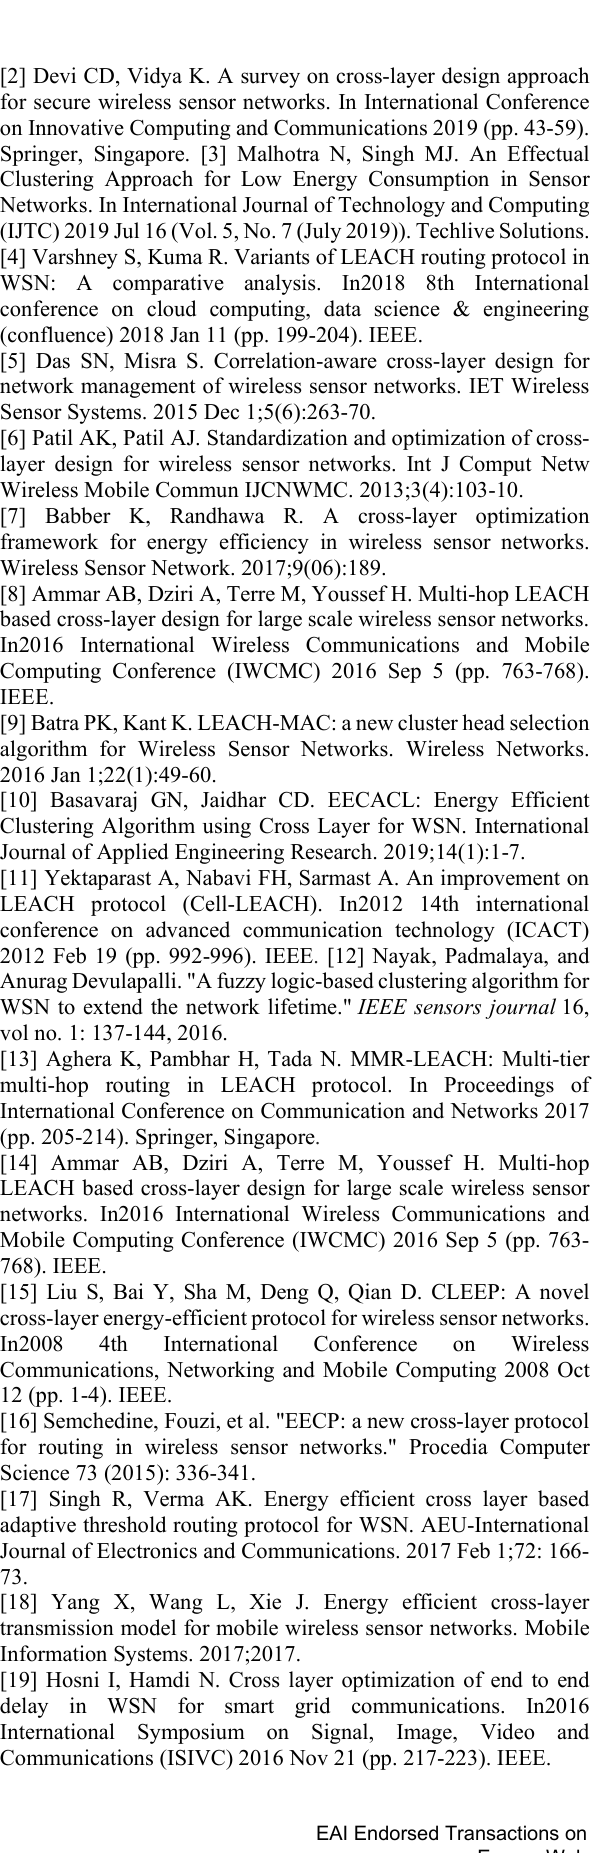
Figure 17. Delay Comparison Graph of CLEES-LEACH and existing EEDS, and ILP protocols